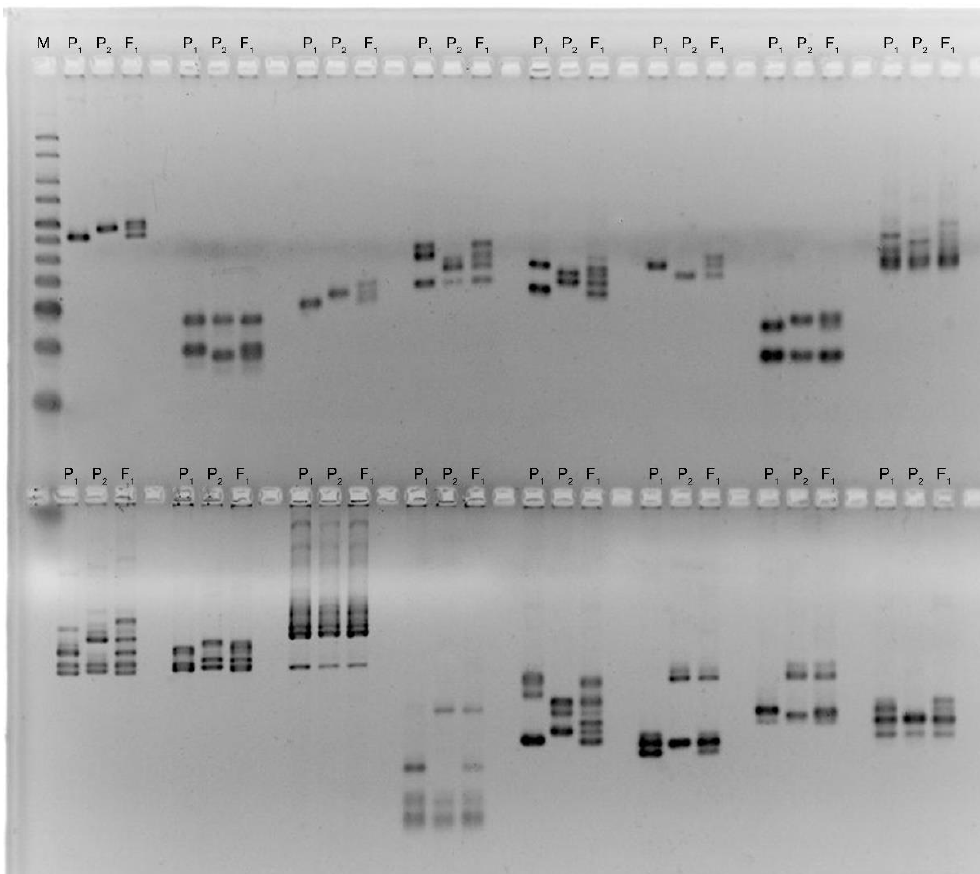
Figure 7 . PCR analysis of parent genotypes and F 1 hybrids using GH primers. P 1 — photoperiod- Figure 7. PCR analysis of parent genotypes and F 1 hybrids using GH primers. P 1 —photoperiod- sensitive wild-type G. hirsutum subsp. purpurascens (var. El-Salvador); P 2 — day-neutral mutant line sensitive wild-type G. hirsutum subsp. purpurascens (var. El-Salvador); P 2 —day-neutral mutant line (var. Kupaysin); F 1 — first-generation hybrid. (var. Kupaysin); F 1 —first-generation hybrid.